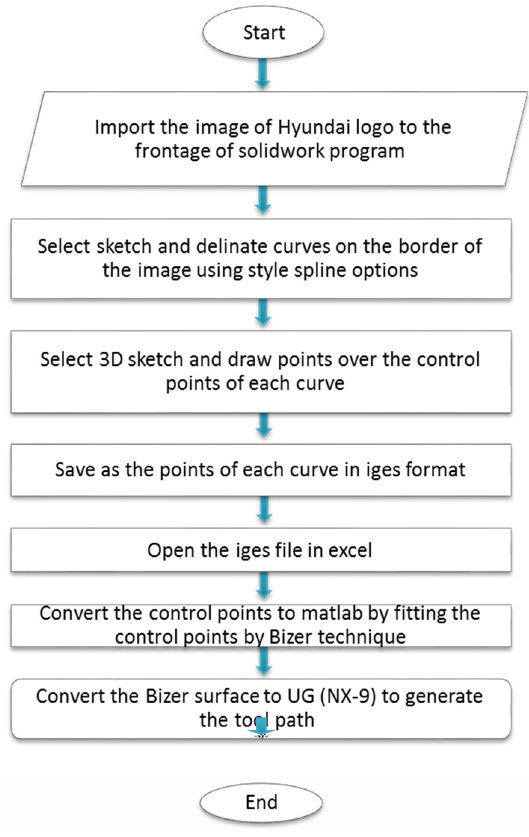
Fig. 1. The flowcharts demonstrate the procedure for recalling the control point using solid work program.